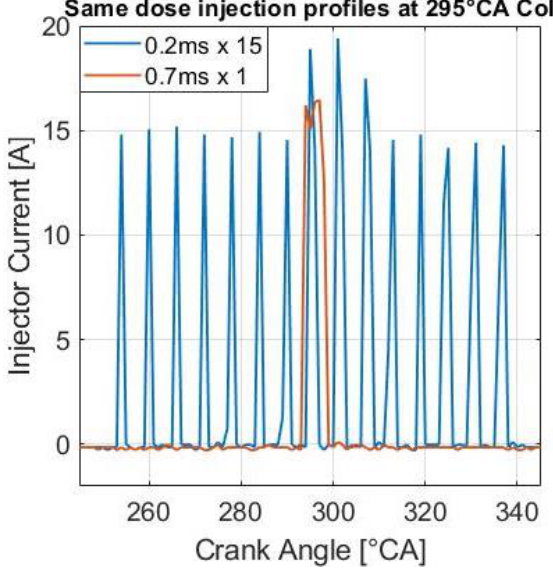
Figure 2. Examples of two comparable injection structures. The doses are the same and both CoIs are 295 °CA.